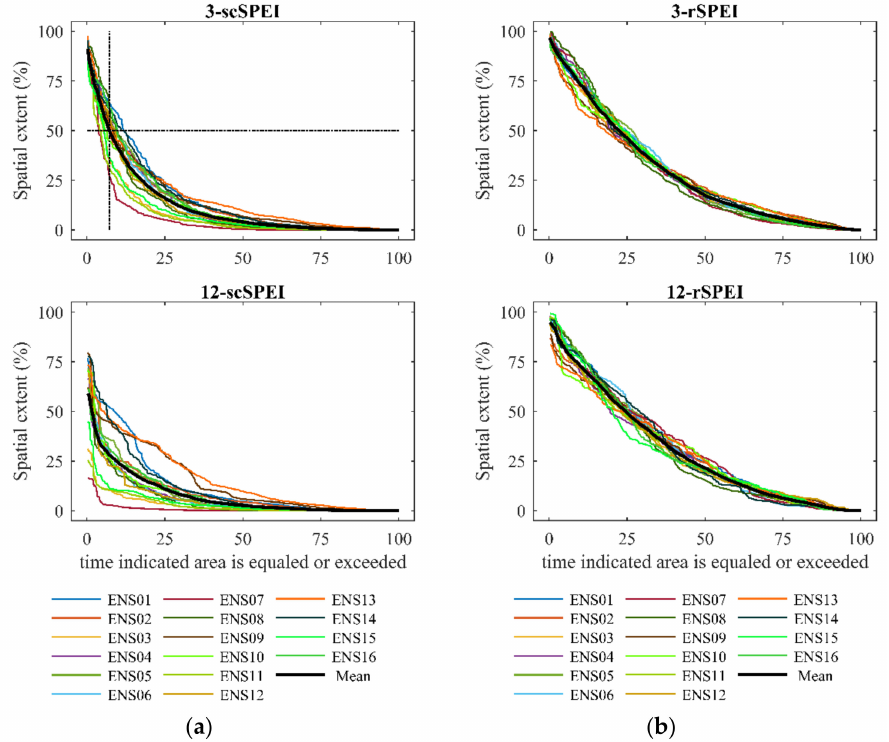
Figure 4. Areal extent-duration curves for indices computed at 3- and 12-month timescales for the recent past for ( a ) scSPEI (using 1980–2099 as reference period), and ( b ) rSPEI (with 1980–2009 as reference